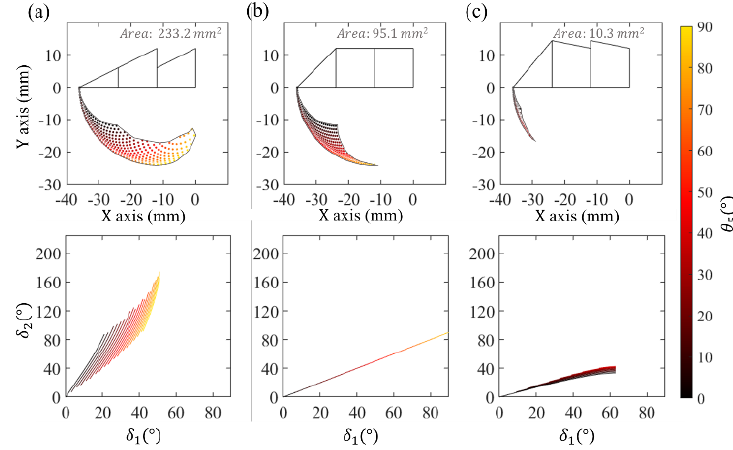
Figure 11. Scatter plots ( top ) and input – output angle relationships ( bottom ) of the double four-bar linkage structures when h 1 = 1.0 L with length ratios ( a ) R = 0.5, ( b ) R = 1.0, and ( c ) R = 1.2. The values of the double four- bar linkage adaptive finger’s initial angles and 𝜓